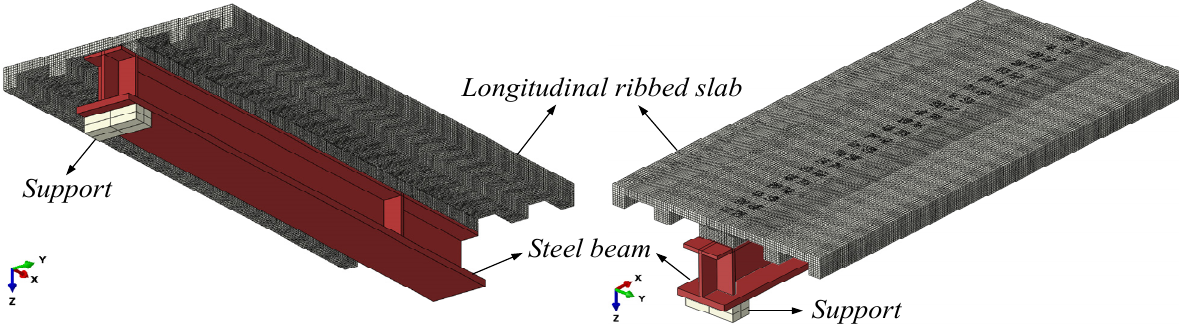
Figure 9. Finite element model.